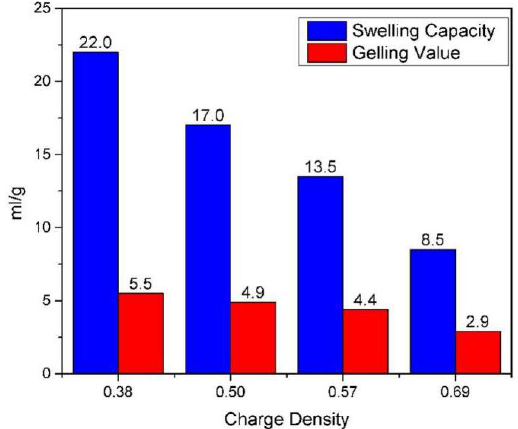
Figure11. Theswellingcapacityandgellingvalueofmontmorillonitewithdi ff Figure 11. The swelling capacity and gelling value of montmorillonite with different layer charge density.